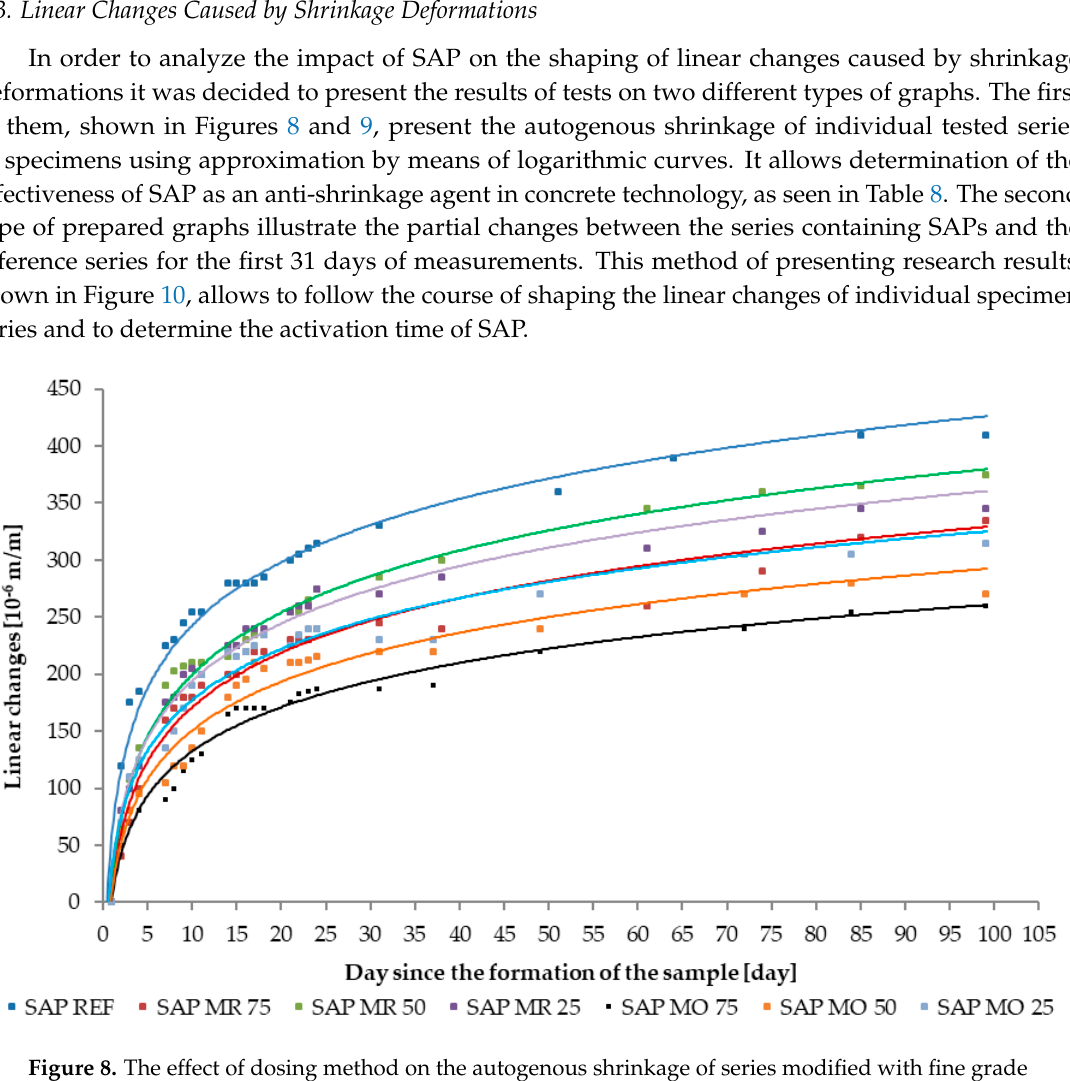
Figure 9. The effect of type of superabsorbent polymers (SAP) (SAP M and SAP D) on the autogenous shrinkage. The linear changes axis presents shrinkage, not expansion.